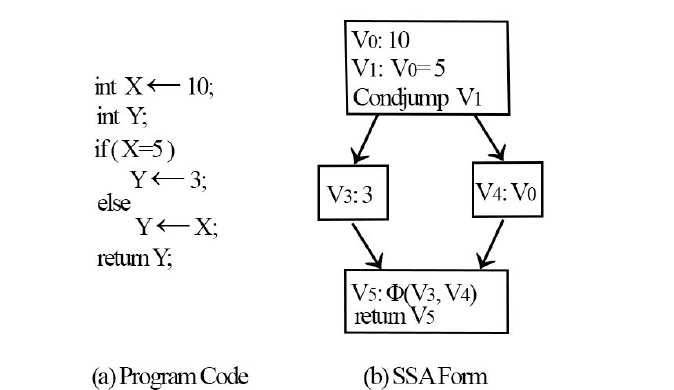
Figure 5. An example of program code converted to SSA form.